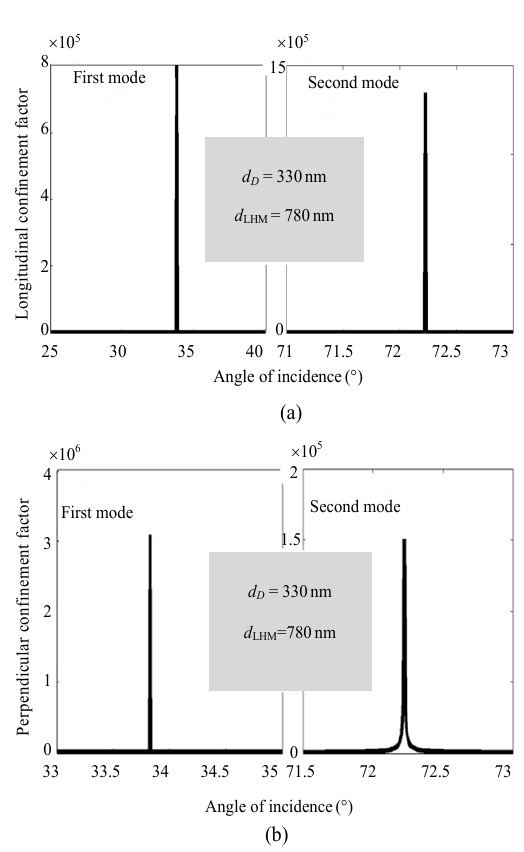
Fig. 4 Angular dependency of the interface’ modes displayed on (a) the perpendicular and (b) the longitudinal confinement factors, f and f in the arrangement:   prism-LHM-dielectric gap layer-Au outermost medium, with an LHM layer set to be 780 nm., and dielectric layer is set to be 330 nm. The other medium parameters are the same as those reported in the inset of Fig.